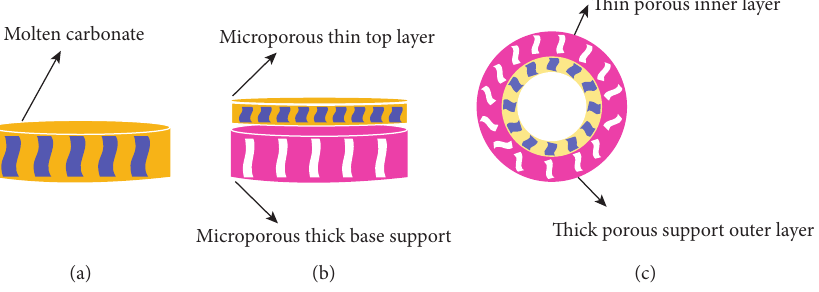
Figure 5: Different geometries of MC membranes. (a) Symmetric disc, (b) asymmetric disc, and (c) asymmetric